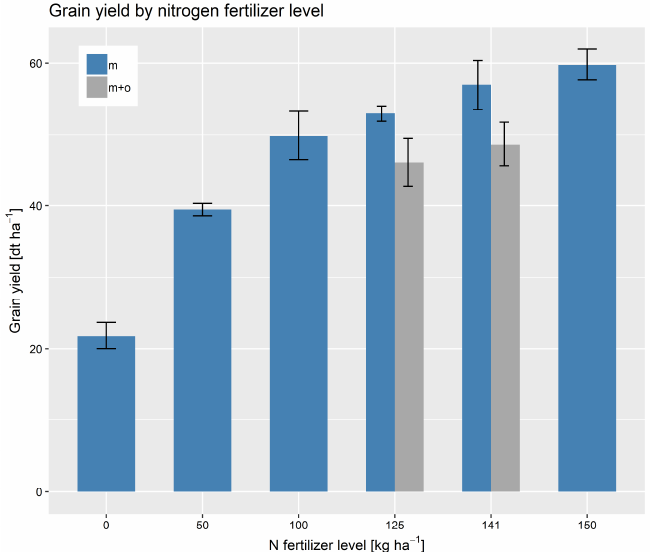
Figure 6. Mean harvest results (three samples each) for six N levels with grain yield at 86% dry matter. Error bars indicate standard error of the mean. Error bars indicate standard error of the